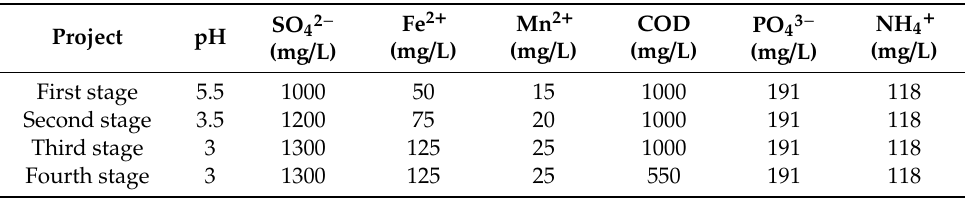
Table 2. Water quality index of dynamic experimental